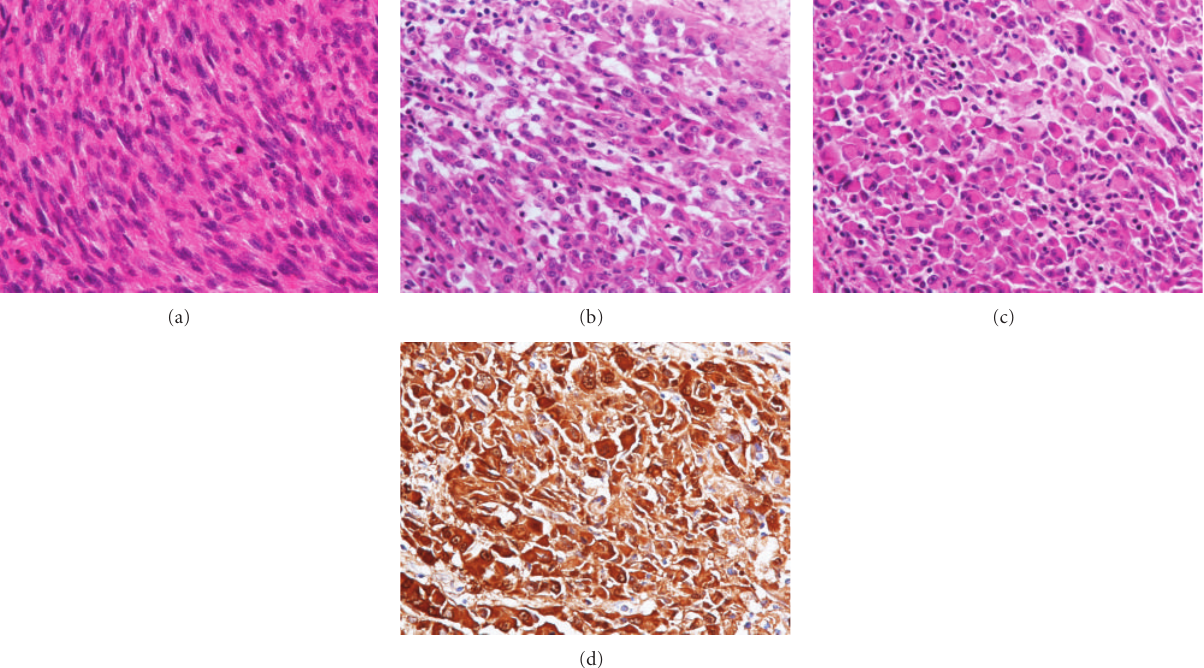
Figure 4: Histological findings. (a) Proliferation of spindle cells with abnormal mitotic activities reminiscent of conventional malignant schwannoma (hematoxylin-eosin, × 400). (b), (c) Epithelioid features of round-to-polygonal or rhabdoid cells with cellular atypia resembling malignant melanoma (hematoxylin-eosin, × 400). (d) Immunohistochemical staining demonstrating strongly positive for S-100